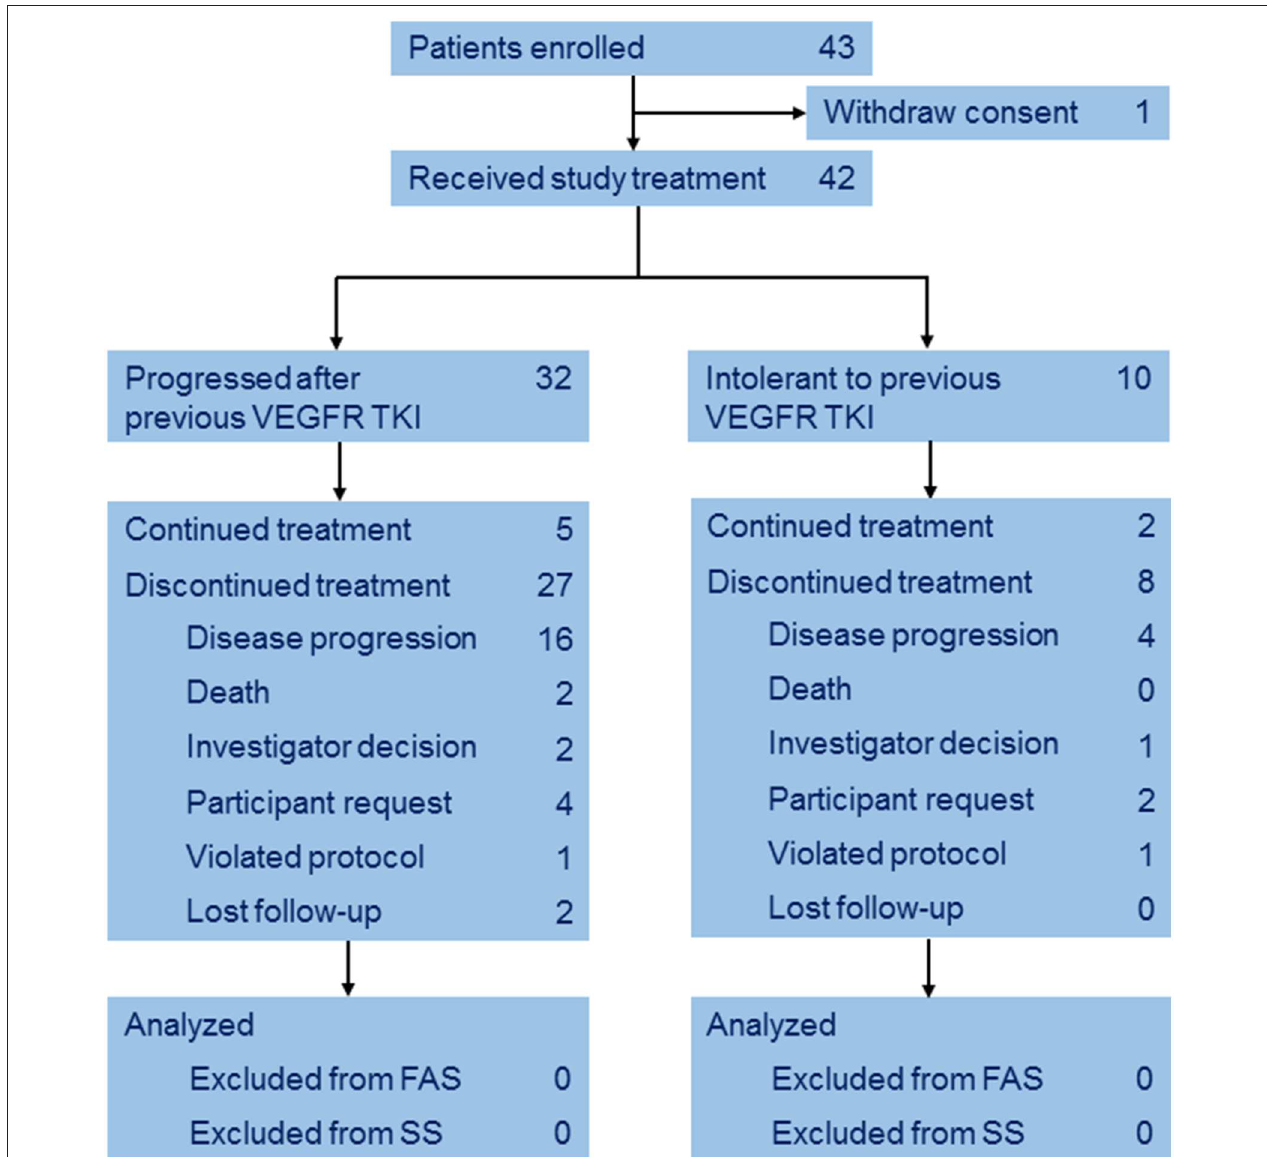
FIGURE 1 | CONSORT